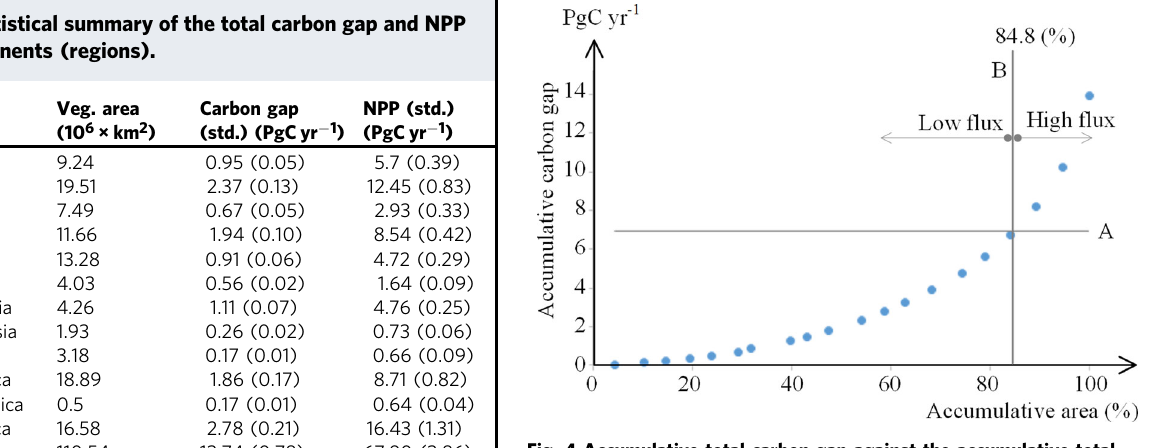
Fig. 4 Accumulative total carbon gap against the accumulative total vegetated area. The whole vegetated area is fi rst sliced into sub-areas using the percentiles of carbon gap fl ux (from low to high) at an interval of 5%, i.e., 0~5%, 5~10%, … , and 95~100%. The accumulated area in the order of the percentiles is depicted on the X axis. The corresponding accumulated total carbon gap is shown on the Y axis. The horizontal line (A) shows the location of half (50%) of the accumulative total carbon gap. The vertical line (B) denotes the location of the separator that divides the accumulated areas into two equal parts (low fl ux side and high fl ux side), where both sides collect half (50%) of the total carbon gap. While representing only ~15% of the total area, the high fl ux side collects half of the total carbon